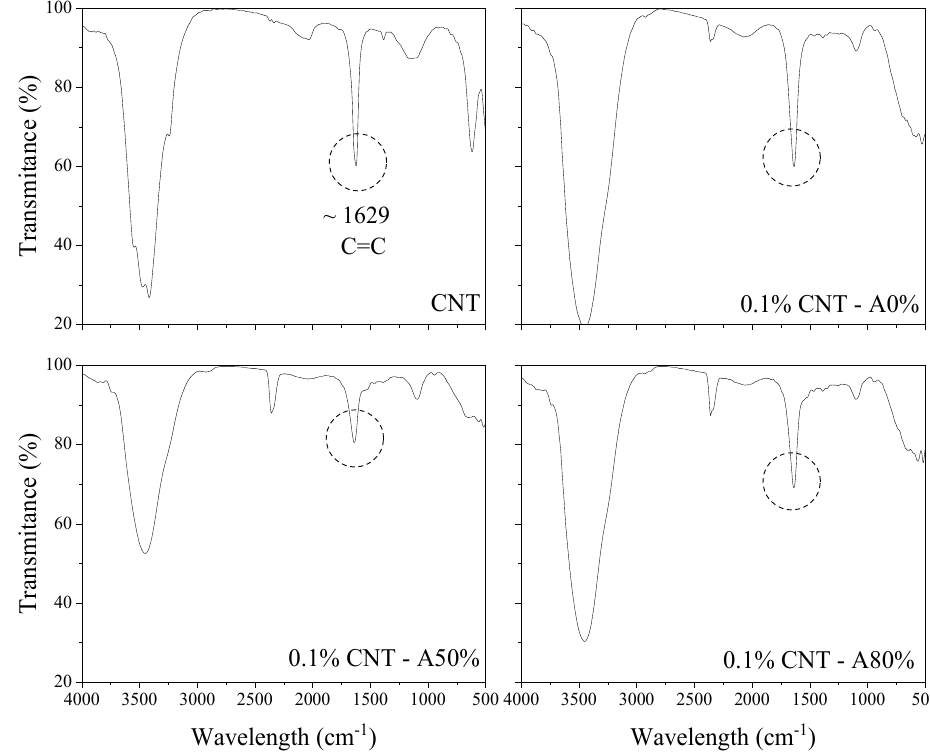
Figure 6. FTIR spectra of polycarboxylate-based superplasticizer and 0.1% CNT dispersions.